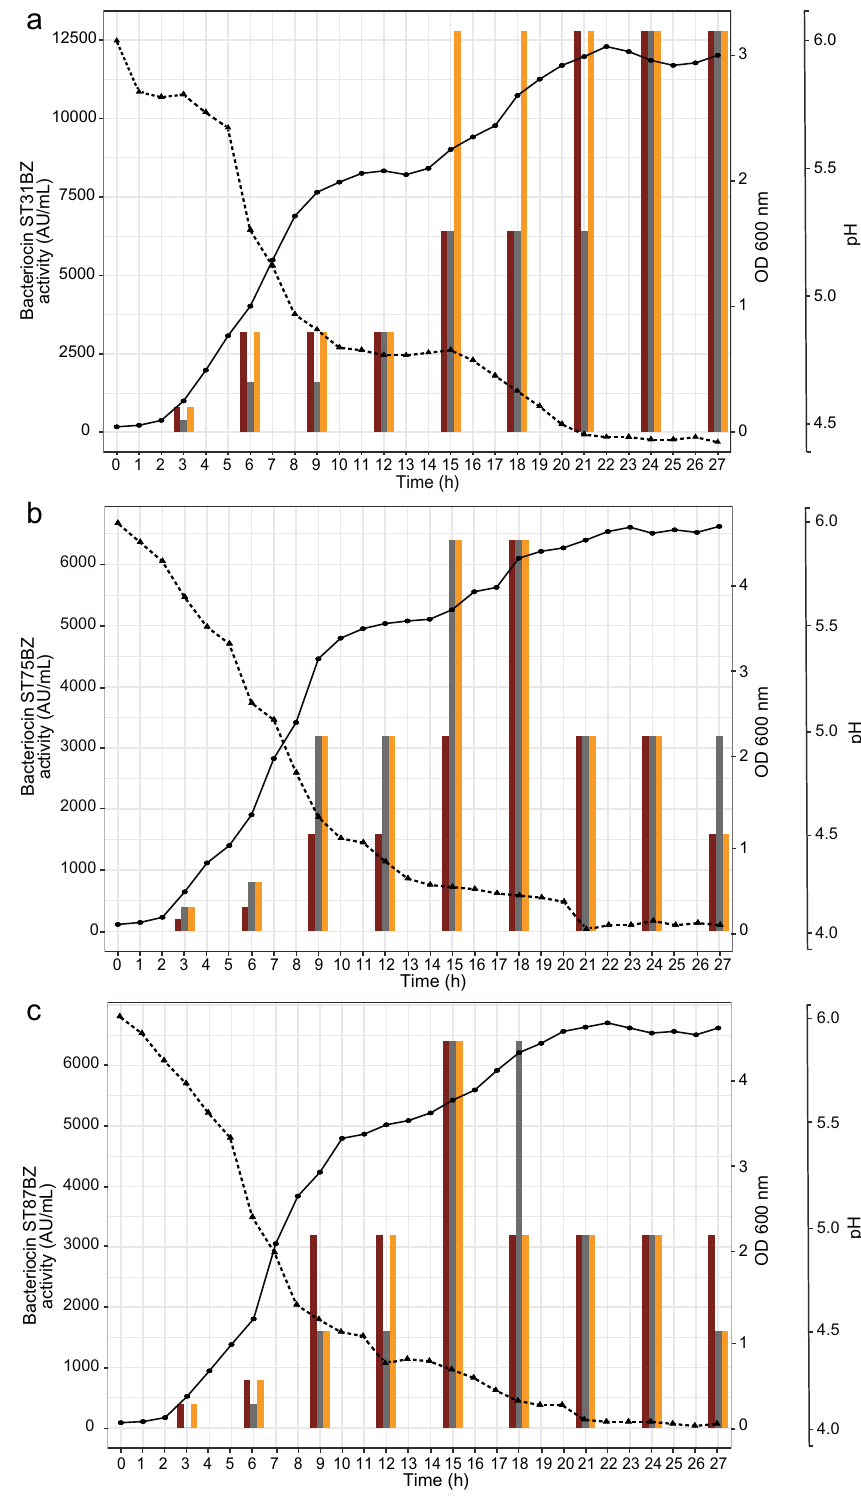
Figure 4. Bacterial growth. Growth changes were monitored as changes in OD 600 nm (- ● -), pH (- ▲ -) and the production of bacteriocins evaluated (mean from 3 experiments is shown), against Listeria monocytogenes 104 (dark-red bar), Listeria monocytogenes 637 (grey bar) and Listeria monocytogenes 711 (mustard bar) expressed as AU/mL presented as histogram for ( a ). Pediococcus acidilactici ST31BZ, ( b ) Pediococcus pentosaceus ST75BZ and ( c ) Pediococcus pentosaceus